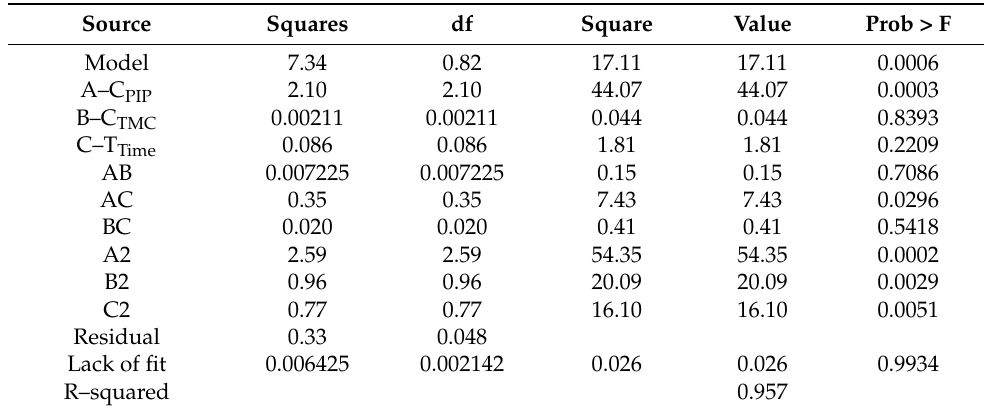
Table 3. Variance analysis of IP–ZrO 2 /BC–NFM quadratic polynomial model for water flux.